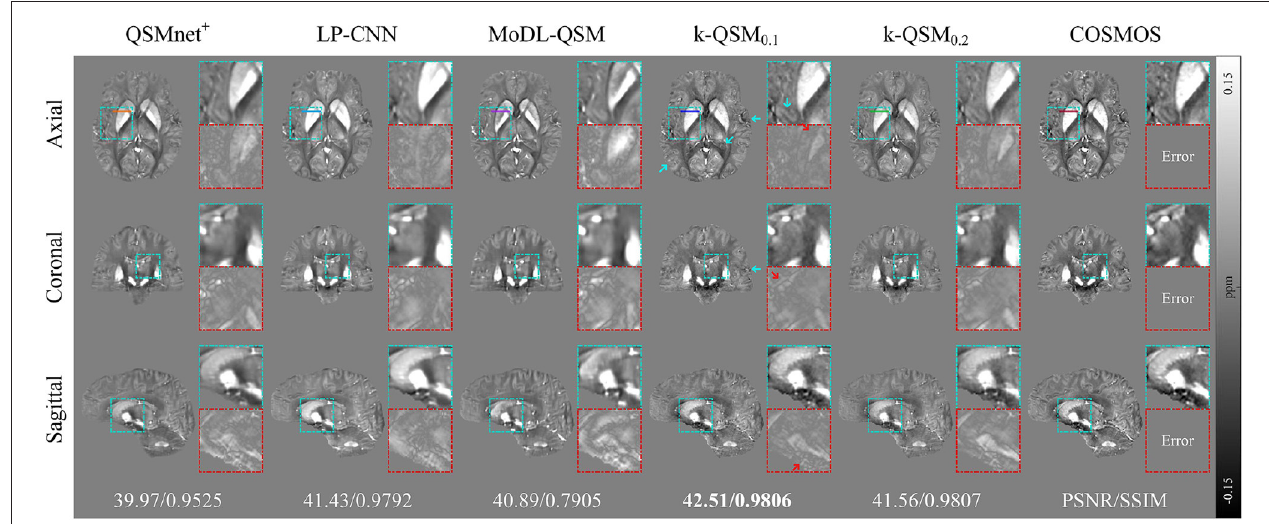
FIGURE 6 | Three orthogonal views of reconstructed quantitative susceptibility mapping (QSM) (average of 12 orientation samplings) using different deep-learning methods, with zoomed-in details (cyan boxes) and errors (red boxes), and global peak signal-to-noise ratio (PSNR) and structural similarity (SSIM) with respect to calculation of susceptibility through multiple orientation sampling (COSMOS) reported below. Red arrows mark the lower error of k-QSM and cyan arrows indicate richer details.